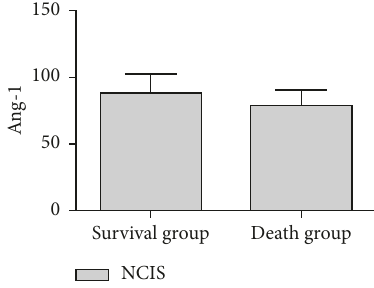
Figure 6: Comparison of NCIS scores in children with RDS with different prognosis.